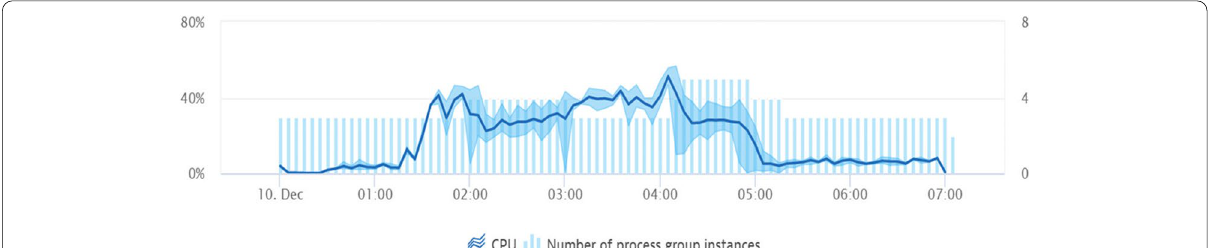
Fig. 18 Average CPU utilization of EasyTravel Frontend of all instances